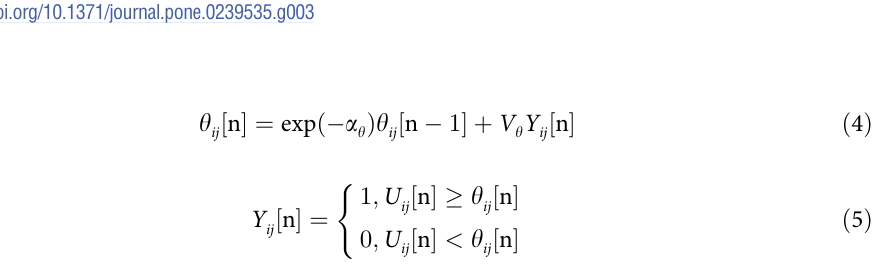
Fig 3. Basic structure of pulse-coupled neuron.